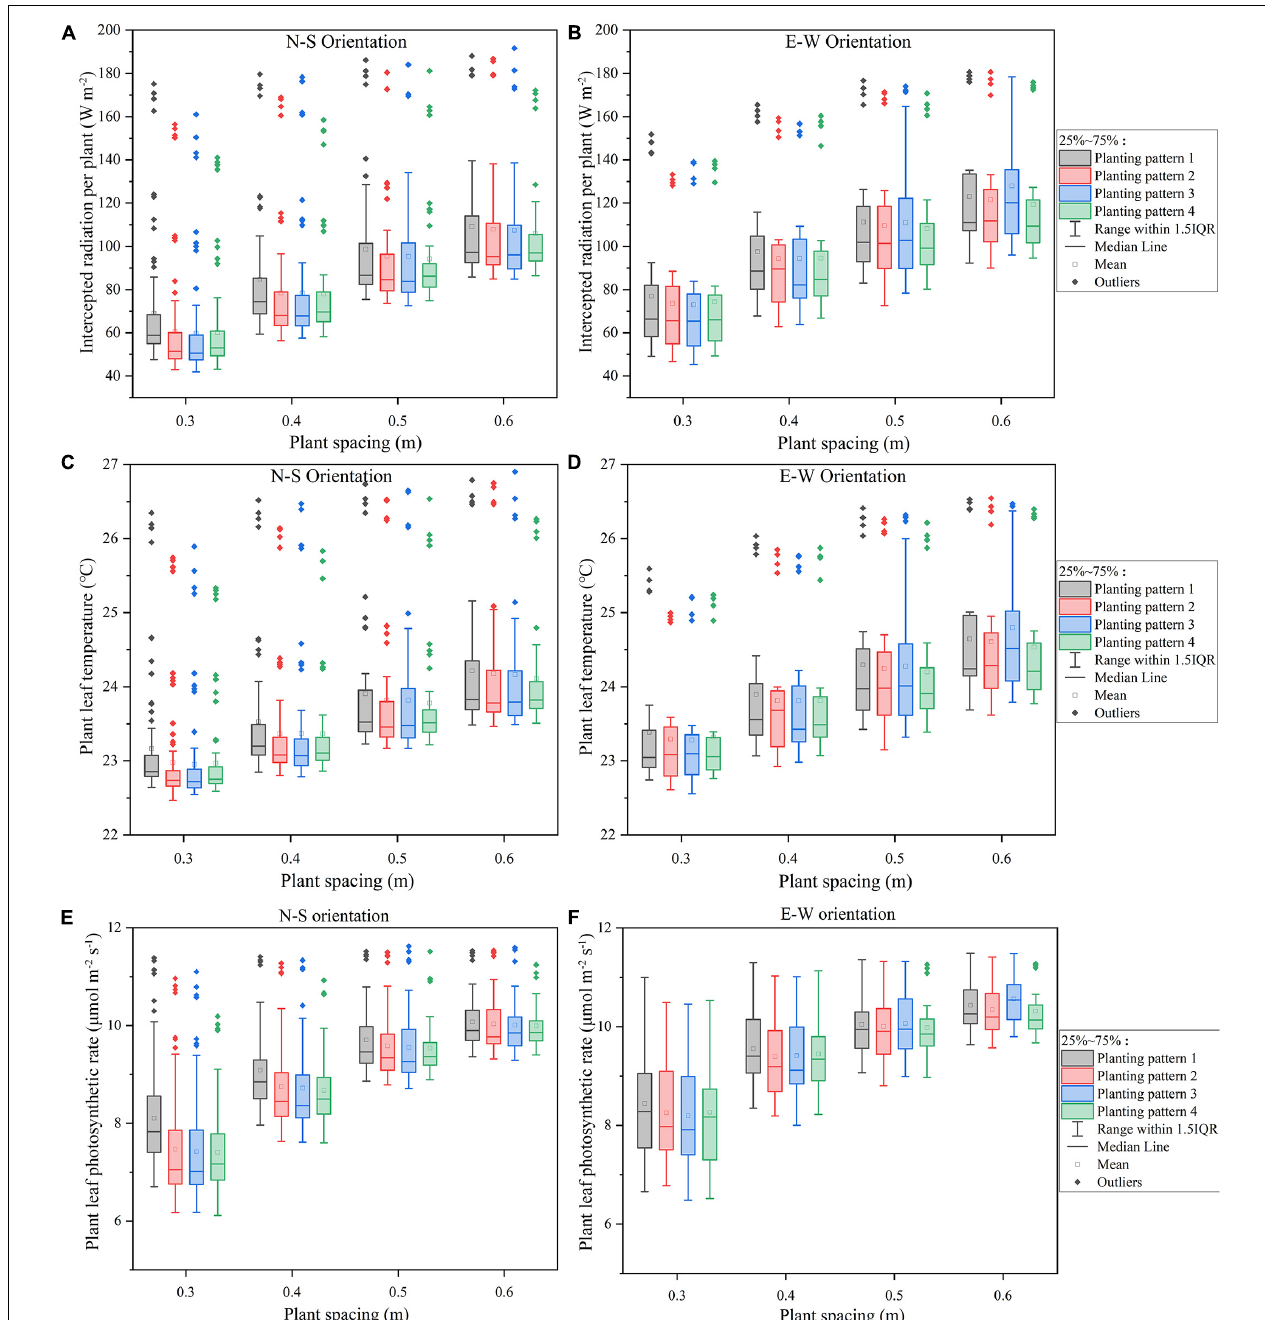
FIGURE 6 | The midday plant solar radiation interception (A,B) , leaf temperature (C,D) , photosynthesis (E,F) of the four planting patterns under N–S orientation (A,C,E), and E–W orientation (B,D,F) as the plant spacing increases.